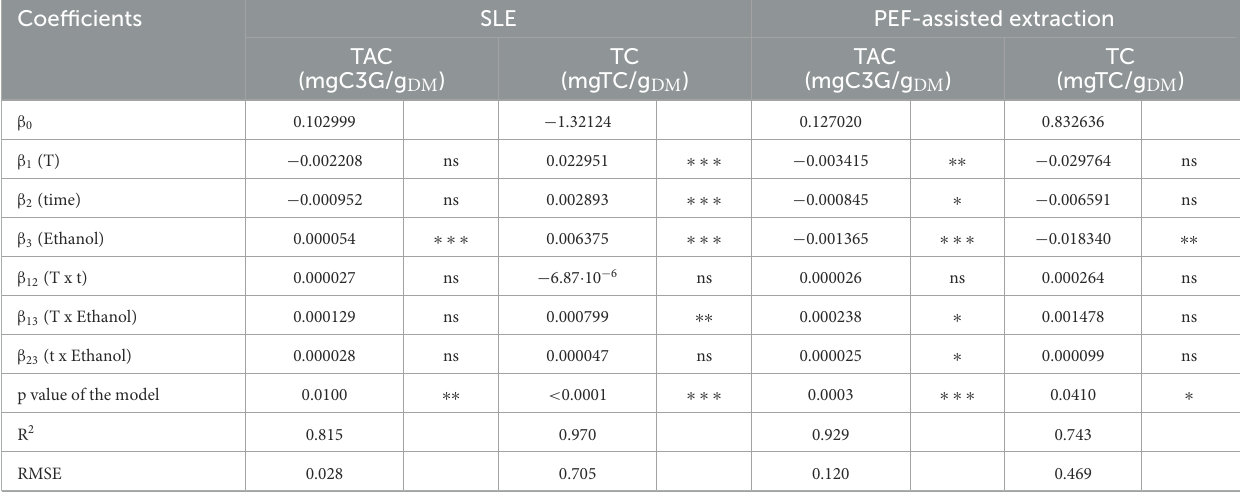
TABLE 6 Analysis of variance (ANOVA) of the two-factor interaction (2FI) model describing the influence of the SLE extraction parameters on the TAC and TC of untreated and PEF (4.6 kV/cm, 20kJ/kg)-treated grape pomace. Coefficients SLE PEF-assisted